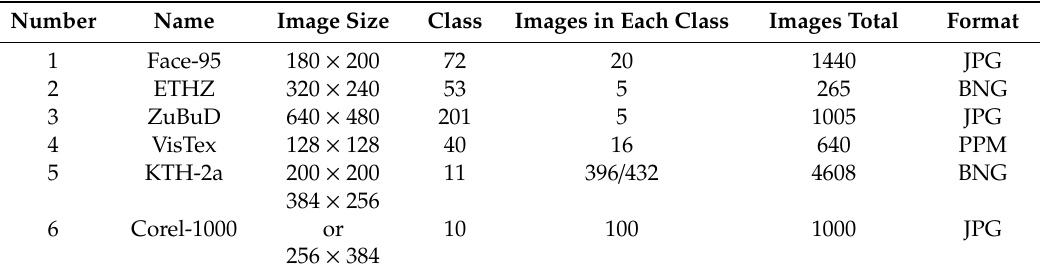
Table 1. Summary of six image datasets.